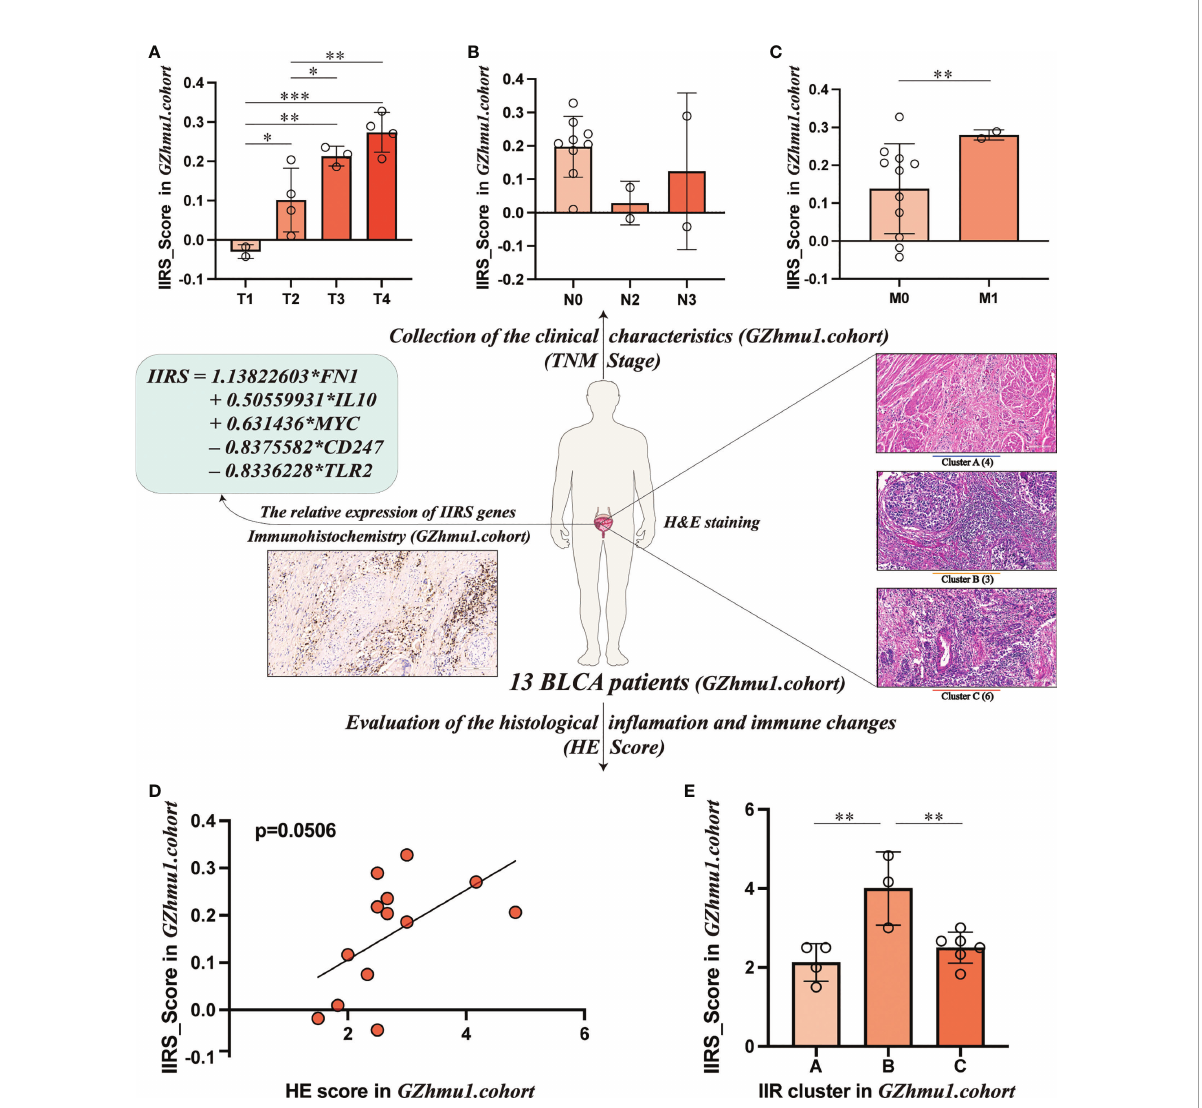
FIGURE 7 Evaluating the clinical application potential of IIRS-score in GZhmu1.cohort. (A-C) Differences in the IIRS-score among different TNM groups. (D) The correlation between IIRS-score and HE-score. (E) Distributions of IIRS-score among clusters. (***P< 0.001; **P< 0.01; *P<